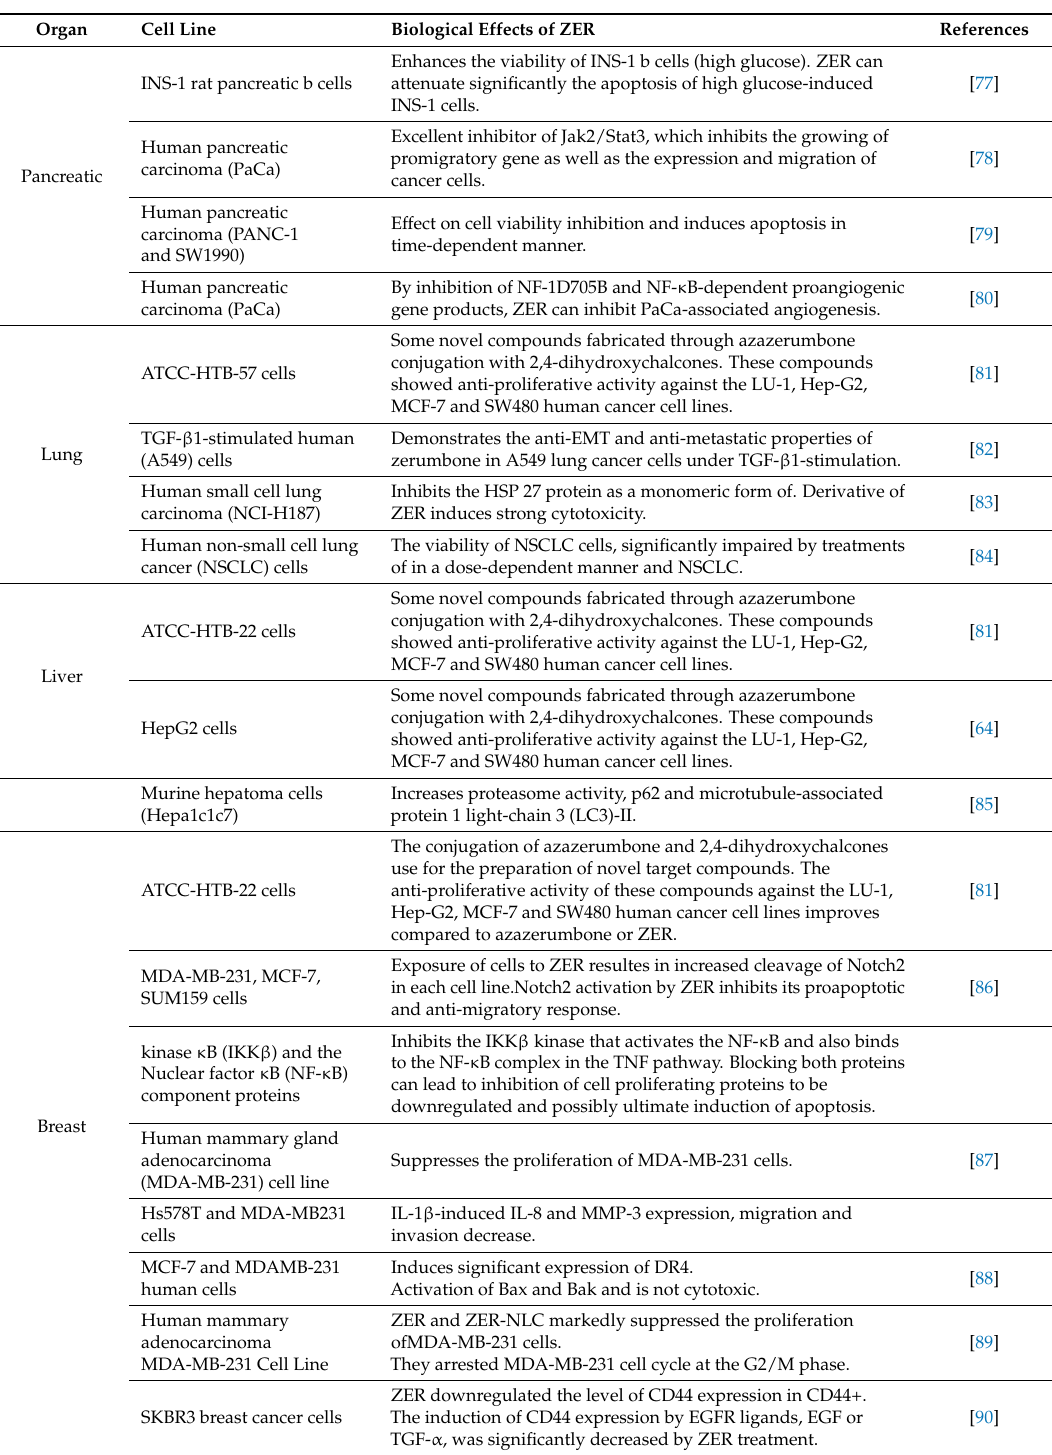
Table 1. In vitro biological effects of